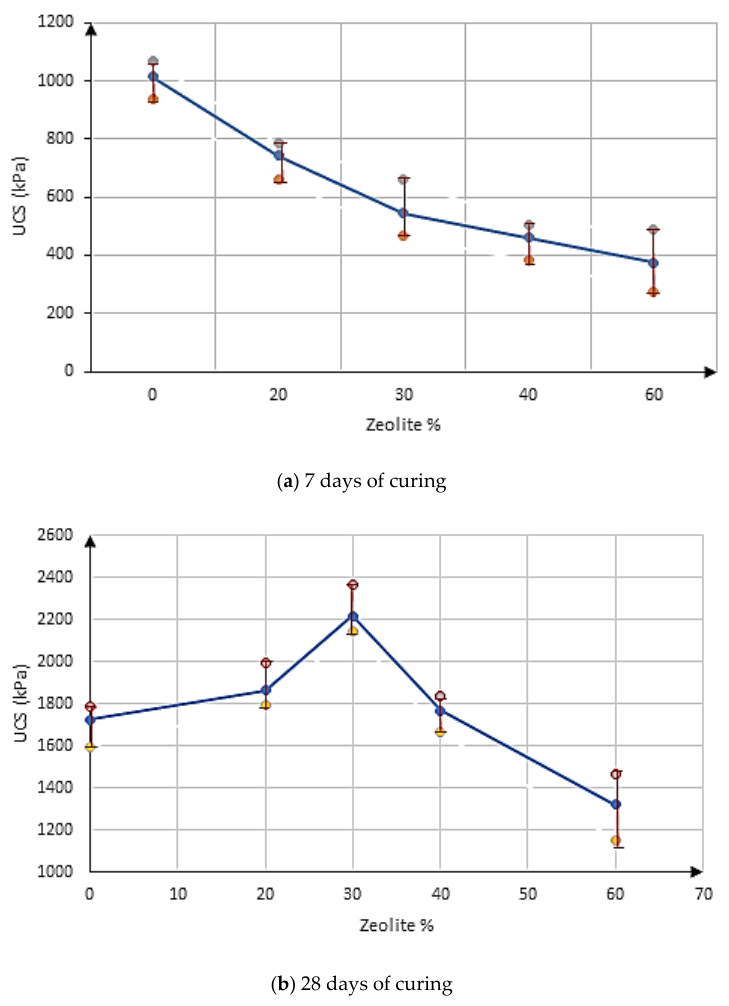
Figure 8. The range bars for changes of USC in different percentages of zeolite as a replacement to cement: ( a ) 7 days, ( b ) 28 days.